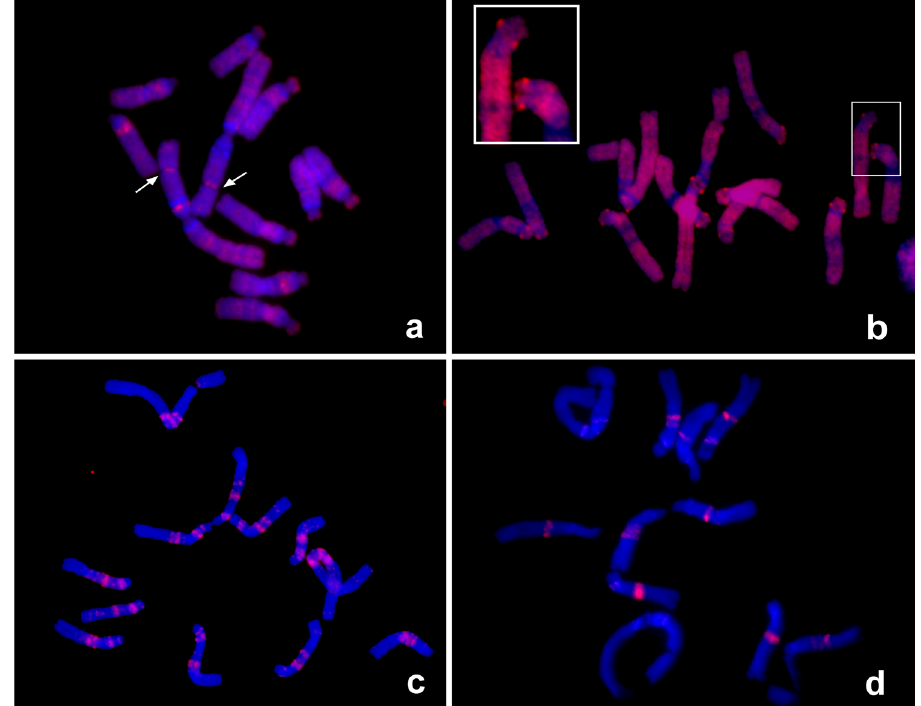
Figure 5. DNA replication assay. Examples of EdU labeling of early ( a ), mid ( b ) and late ( c–d ) replicated chromatin. Arrows in panel (a) show the positions of early replicating NORs. The inset in panel (b) shows a detail of two chromosomes, with bright spots corresponding to labeled centromeres. The two late replication patterns that could be distinguished consisted of labeling most satellite repeats ( c ), followed by exclusive labeling of FokI loci, which represented the last genomic sequences to be replicated ( d